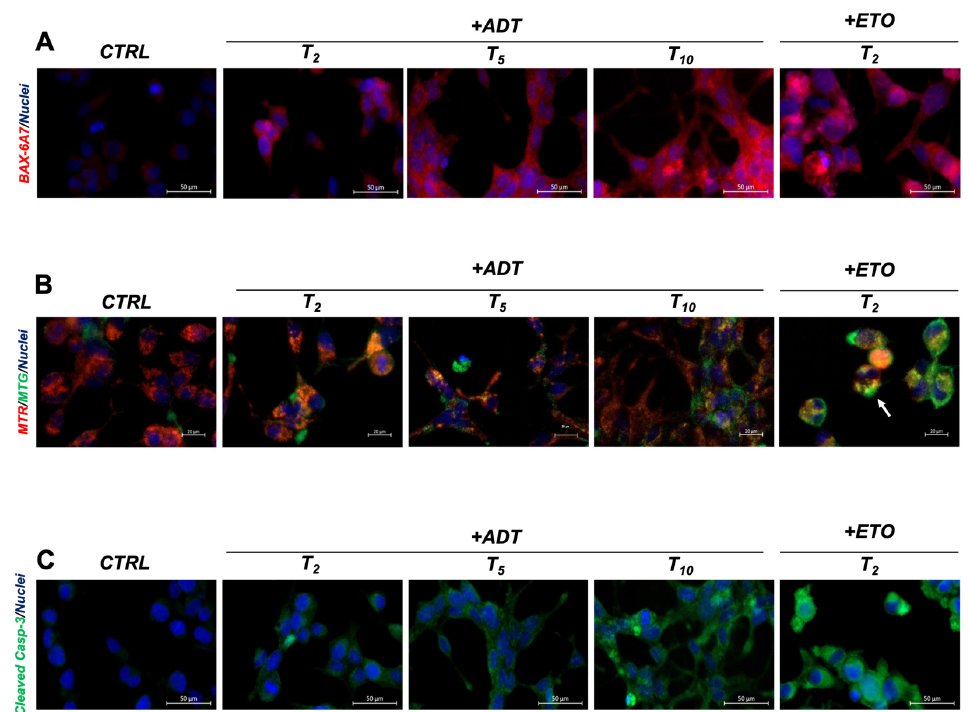
Figure 2. ADT activates the intrinsic apoptotic pathway without affecting cell viability. ( A ) ADT induces time-dependent sub-apoptotic activation of BAX. Immunofluorescence with anti-activated- BAX (6A7) antibody (red) and DAPI (blue) for nuclei, in wide-field micrography. The scale bar corresponds to 50 µ m. ( B ) ADT alters the mitochondrial activity in the whole cell population. The prevalent red pattern of untreated cells (T0) turns into a prevalent orange/yellow pattern during ADT. Live cells staining of the mitochondrial mass (MTG, green), mitochondria with high transmembrane potential, mt ∆Ψ (MTR, red) and cell nuclei (Hoechst, blue) in wide-field micrography. The scale bar corresponds to 20 µ m. ( C ) ADT increases caspase-3 activation in the whole cell population. Immunofluorescence with anti-cleaved caspase-3 antibody (green) and DAPI (blue) for nuclei, in wide-field micrography; the strong green signals correspond to apoptotic cells. The scale bar corresponds to 50 µ m.